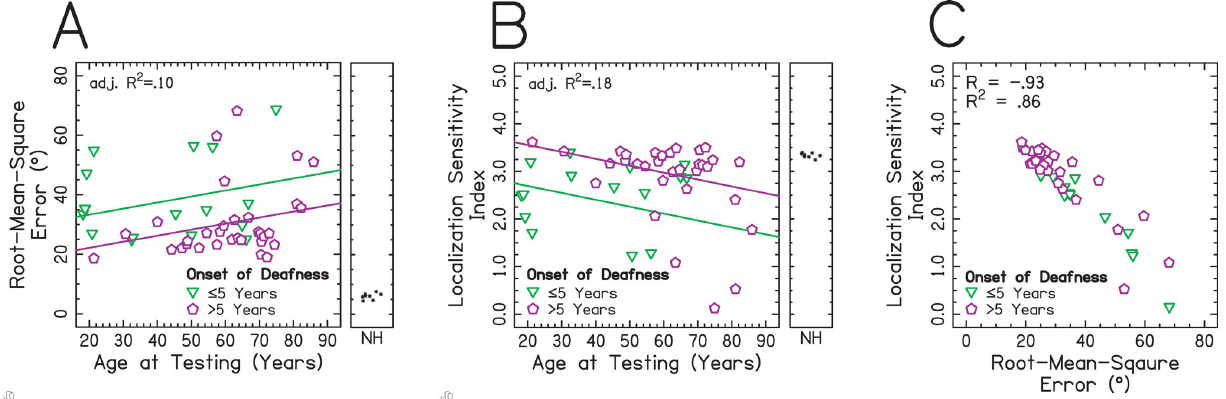
Fig 4. Relationship between RMS error over all target angles, the LSI, and patient-dependent factors. Individuals with an onset of deafness � 5 or > 5 years are shown with green 5 and magenta ⬠ symbols, respectively. (A) The x-axis represents age at testing in years. The y-axis represents the RMS error, where higher values indicate poorer performance. The adjusted R 2 was taken from a regression including factors of onset of deafness group and age at testing. The sub-panel offset to the right shows data from listeners with NH. (B) The x-axis represents the age at testing in years. The y-axis represents the LSI, where lower values indicate poorer performance. The adjusted R 2 was taken from a regression including factors of onset of deafness group and age at testing. The sub-panel offset to the right shows data from NH listeners. (C) The x- and y-axes represent the LSI and RMS error, respectively. The R 2 corresponds to the coefficient of determination taken from a correlation between overall RMS error and the